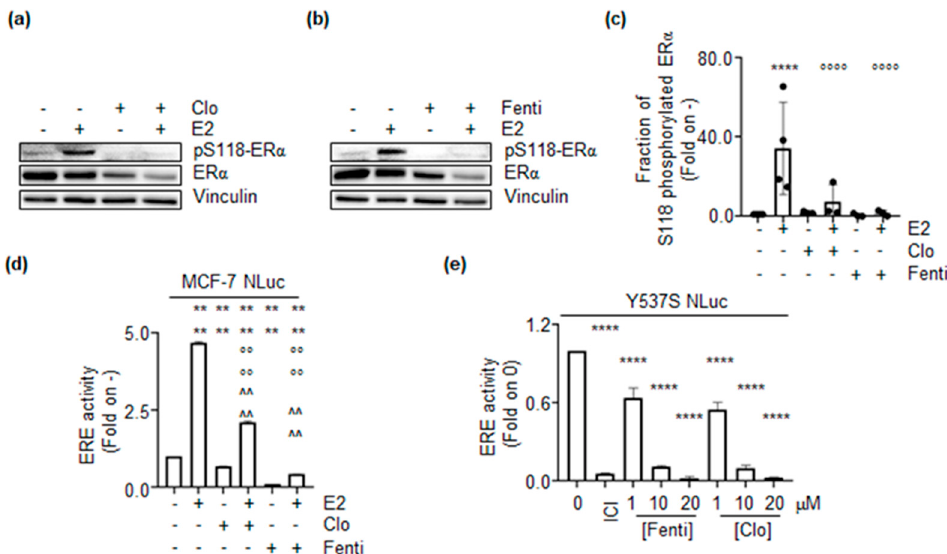
Figure 5. The impact of clotrimazole and fenticonazole on ER α transcriptional activation. Western blotting and analysis of the ER α and the ER α phosphorylation status on S residue 118 (pS118) induced by 17 β -estradiol (E2 1 nM–30 min) in MCF-7 cells pre-treated with clotrimazole (Clo 10 µ M) ( a ) and fenticonazole (Fenti 10 µ M) ( b ) for 72 h. ( c ) Densitometric analysis is relative to panel ( a , b ). The loading control was done by evaluating vinculin expression in the same filter. Panels show representative blots of three independent experiments. Significant differences with respect to-sample are calculated by Student t-test and indicated by **** ( p -value < 0.0001). Significant differences with respect to the E2 sample are calculated by Student t-test and indicated by °°°°( p -value < 0.0001). ( d ) Estrogen response element promoter activity in MCF-7 ERENLuc cells pre-treated with clotrimazole (Clo 10 μ M) and fenticonazole (Fenti 10 μ M) for 72 h and then treated with 17 β -estradiol (E2 1nM) for an additional 24 h. ( e ) Estrogen response element promoter activity in Y537S ERENLuc cells treated with fulvestrant (ICI-100nM), clotrimazole (Clo), and fenticonazole (Fenti) at the indicated doses for 72 h. The experiments were performed twice in duplicate. Significant differences with respect to untreated (i.e., -,-,- or 0) sample are calculated by Student t-test and indicated by **** ( p -value < 0.0001). Significant differences with respect to the E2 sample are calculated by Student t-test and indicated by °°°° ( p -value < 0.0001). Significant differences with respect to Clo- or Fenti- alone treated sample are calculated by Student t-test and indicated by ^^^^ ( p -value < 0.0001).